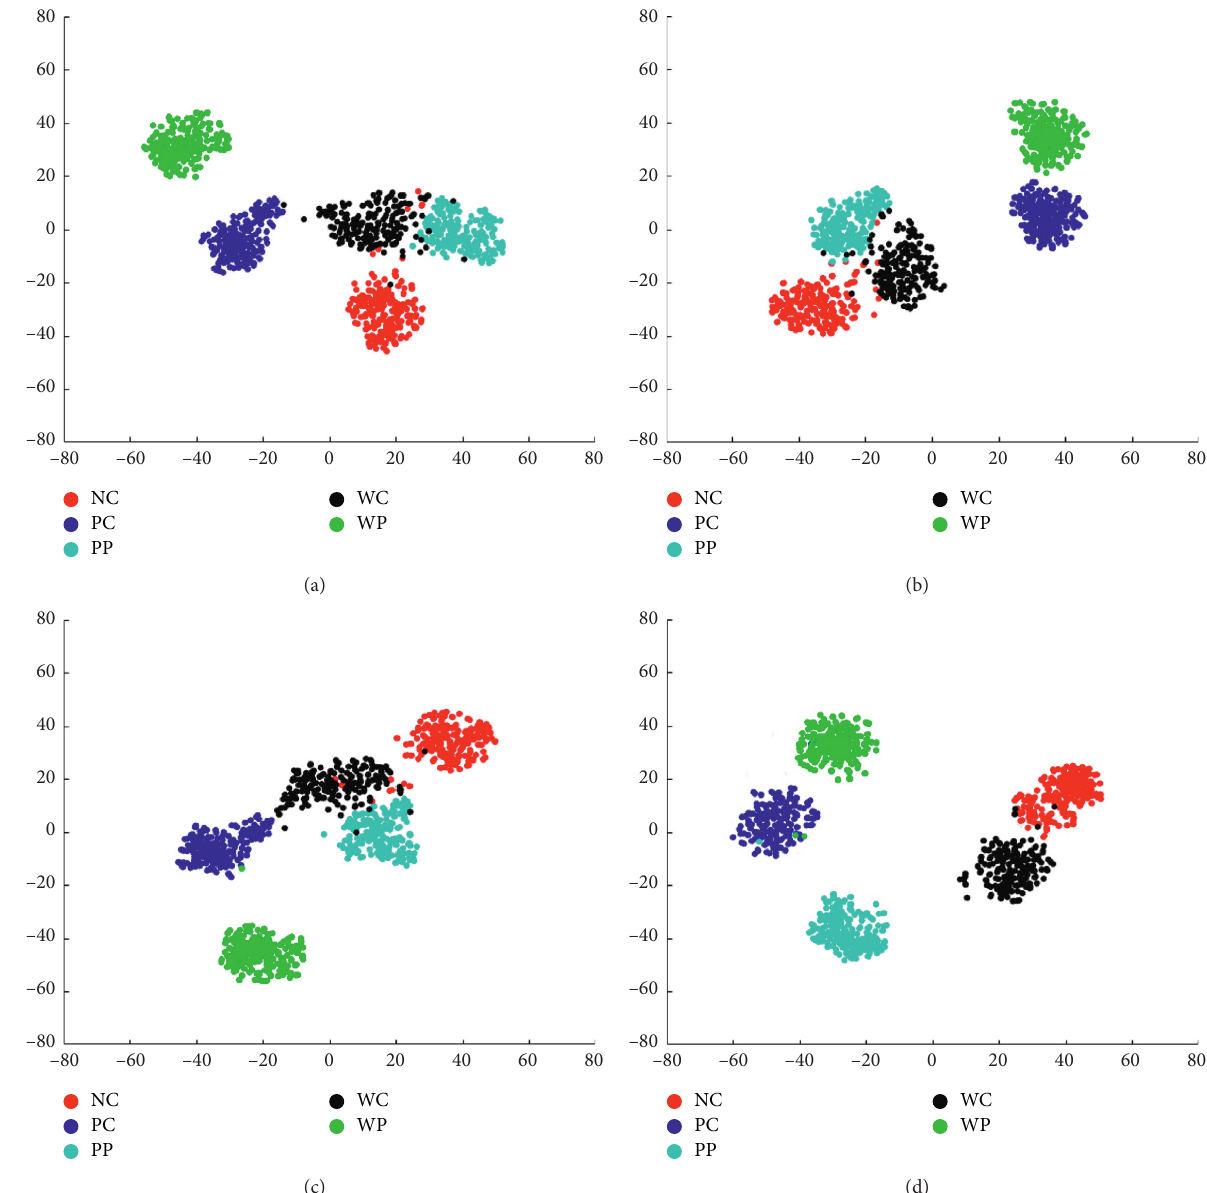
Figure 13: First two dimensions of learned features of the four methods: (a) SF, (b) L1-SF, (c) L2-SF, and (d)